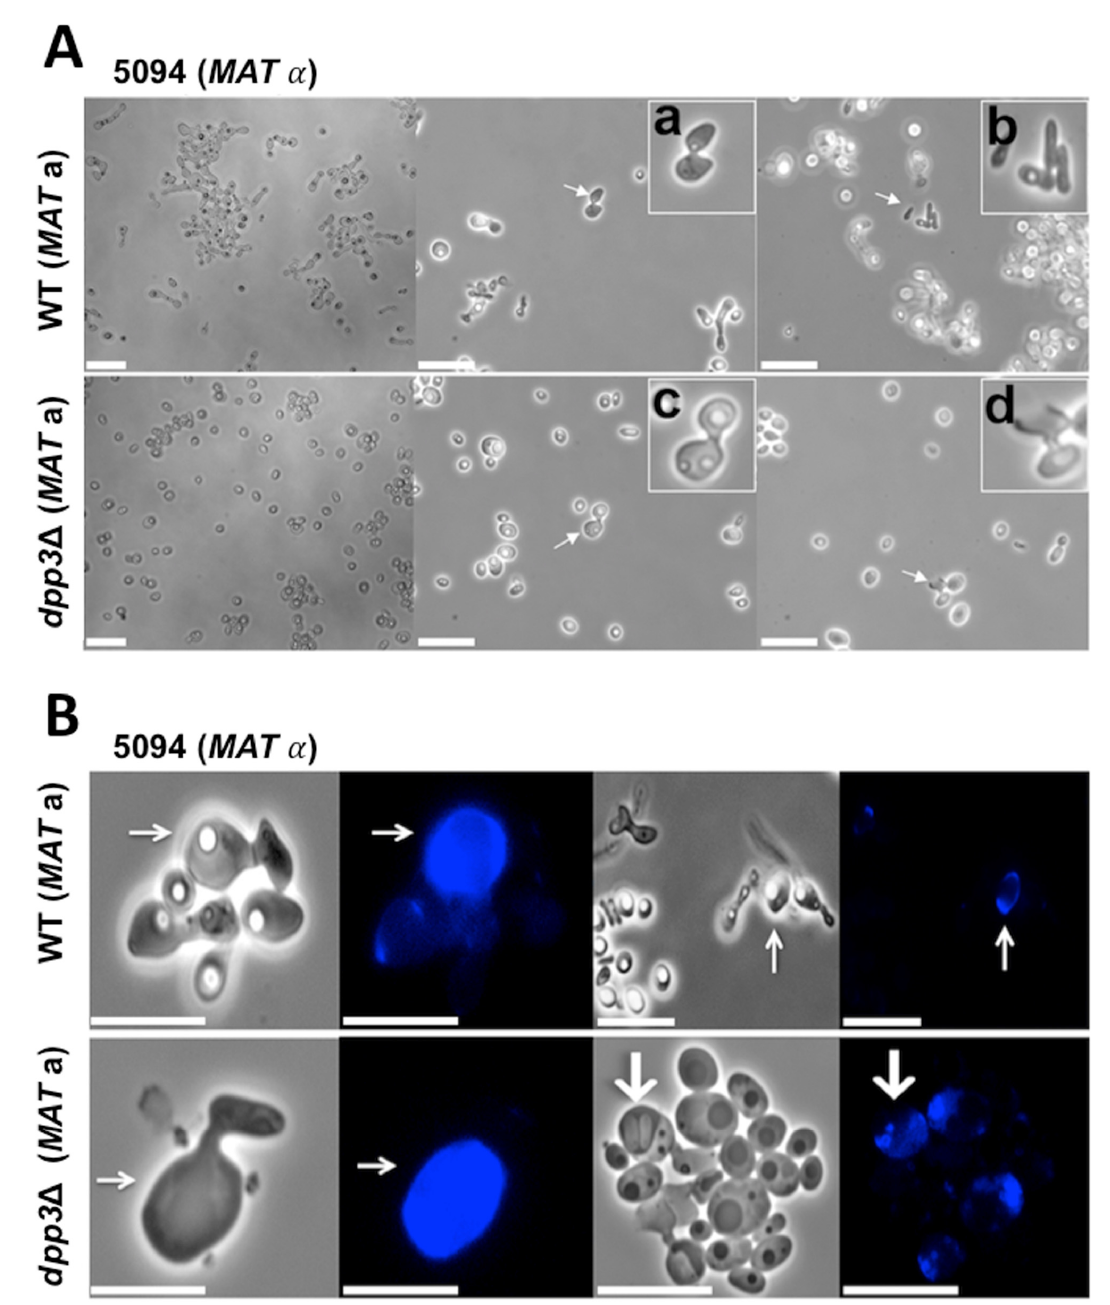
Figure 3. Mating of the WT and dpp3 ∆ strains with the same tester strain. Images were taken after 48 h of incubation at 30 ◦ C. Scale bars represent 10 µ m. ( A ) Mating between the 5094 MAT α and the WT or dpp3 ∆ MAT a strains. Inserts show enlarged views of the cells indicated by arrows. ( a , c ) Sexual conjugation between two yeast cells. ( b ) Ascospores. ( d ) Ascus. ( B ) Mating between the non-stained 5094 MAT α and the CFW-stained WT or dpp3 ∆ MAT a strains. Acceptor cells are indicated by thin arrows, and an ascus is indicated by a thick arrow.